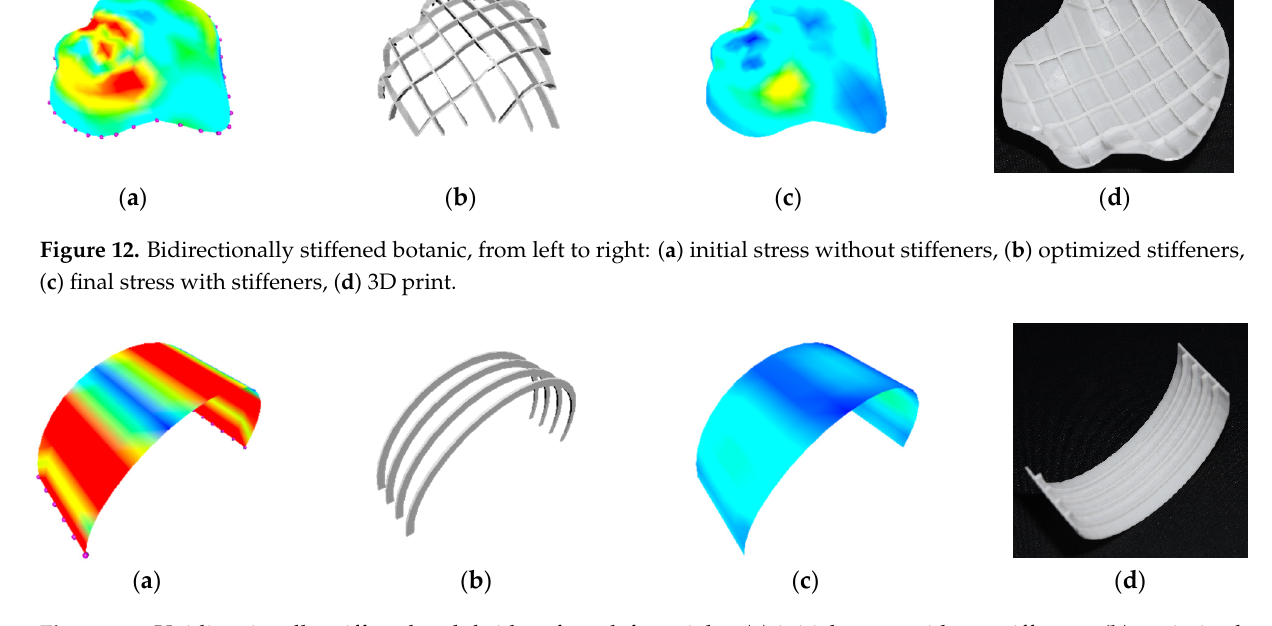
Figure 13. Unidirectionally stiffened arch bridge, from left to right: ( a ) initial stress without stiffeners; ( b ) optimized stiffeners; ( c ) final stress with stiffeners; ( d ) 3D print.